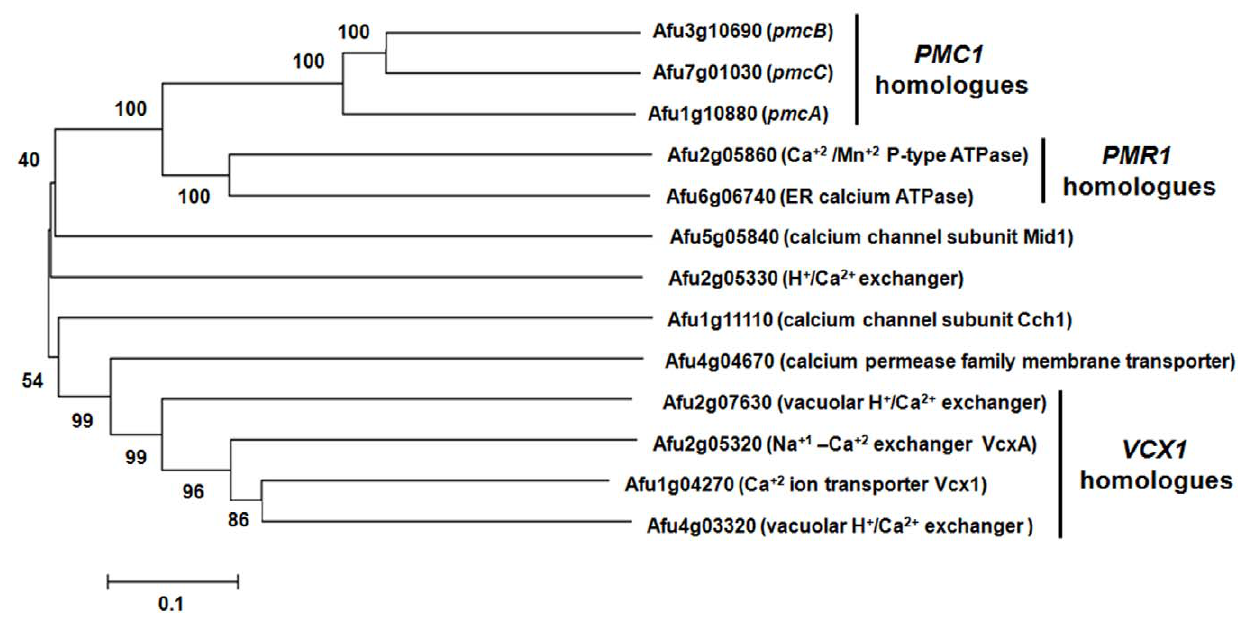
Figure 1. A.fumigatus has three S.cerevisiaePMC1 homologues. Phylogram tree and multiple sequence alignment of calcium transporter orthologues were made in CLUSTAL W2 (http//www.ebi.ac.uk/Tools/clustalw2/index.html) using the default parameters. The followings proteins were used for the analysis: Afu3g10690 ( pmcB ; XP_754550); Afu7g01030 ( pmcC ; XP_746828); Afu1g10880 ( pmcA ; XP_752453); Afu2g05860 (calcium/ mangenese P-type ATPase: XP_749715); Afu6g06740 (endoplasmic reticulum calcium ATPase: XP_750567); Afu5g05840 (calcium channel subunit Mid1: XP_754048); Afu2g05330 (vacuolar H + /Ca2 + exchanger: XP_749663); Afu1g11110 (calcium channel subunit Cch1: XP_752476); Afu4g04670 (calcium permease family membrane transporter: XP_746653); Afu2g07630 (vacuolar H + /Ca2 + exchanger: XP_755098); Afu2g05320 (calcium-proton exchanger: XP_749662); Afu1g04270 (calcium ion transporter Vcx1: XP_750174); and Afu4g03320 (similar to vacuolar H + /Ca 2 + exchanger: